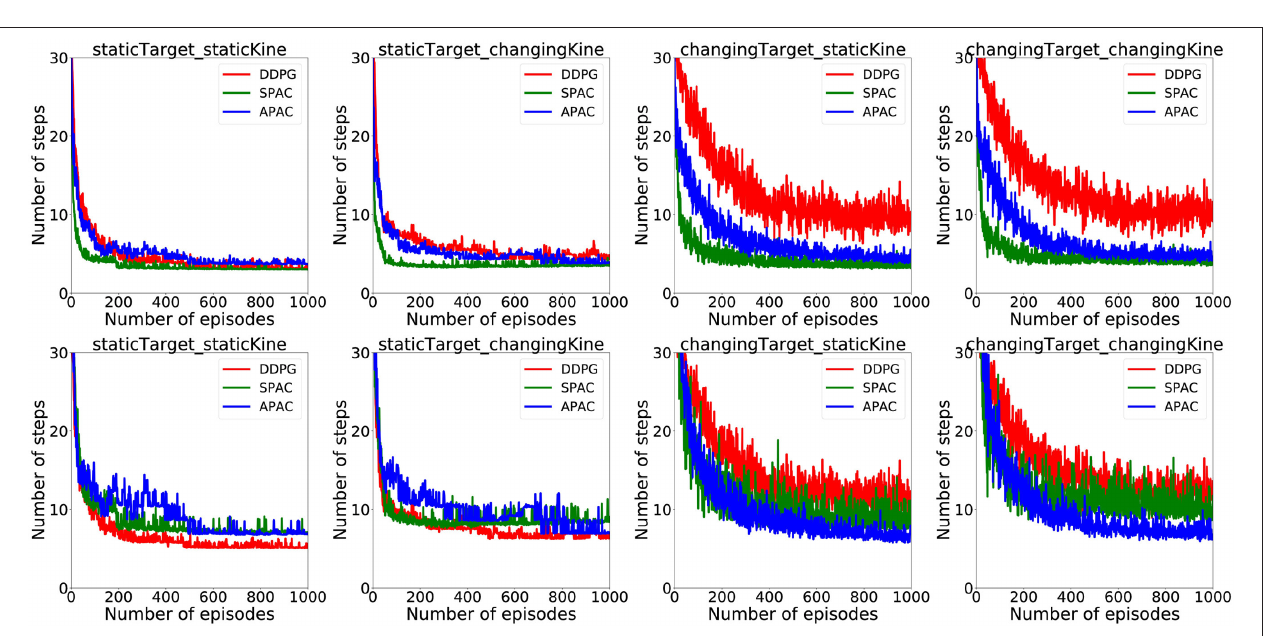
FIGURE 6 | Arbitration between habitual and planning by the APAC: For each condition, the blue line indicates the average number of actions which are selected by the habitual controller (i.e., the actor), while the red line demonstrates the average number of actions selected by the planning controller (i.e., inverse model). Results illustrate that planning controller is used early in the training, while later agent tends to use the habits